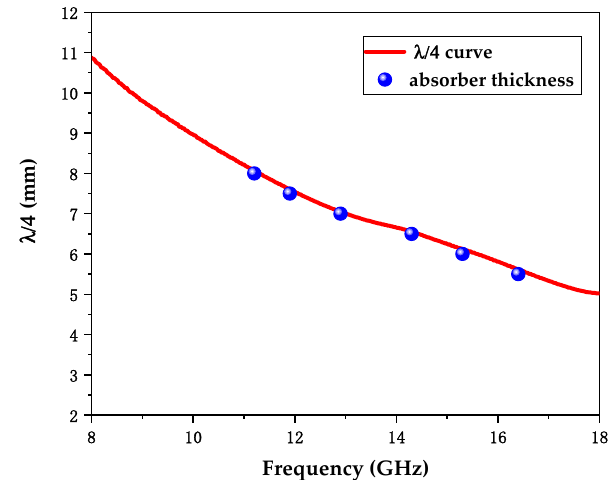
Figure 4. The λ / 4 cancellation model of sample C-60 and the absorber thickness of C-60 versus the corresponding frequency at the RL absorption peak (denoted as blue dots).